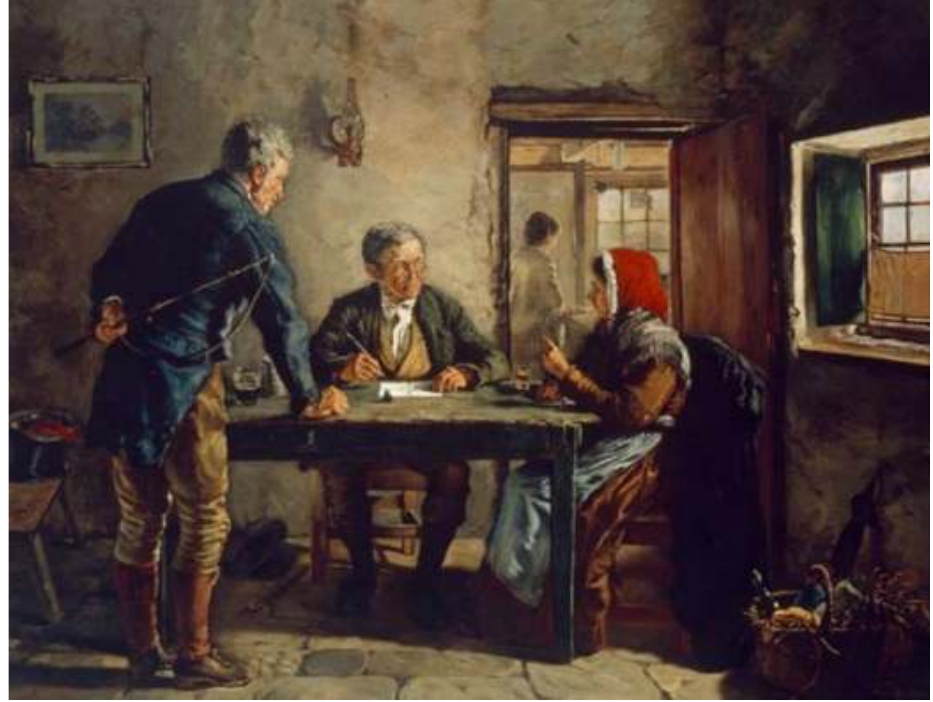
Figure 4: James Brenan, The Village Scribe, oil on canvas, 29 x 24 cm, 1881, Collection of Brian P.